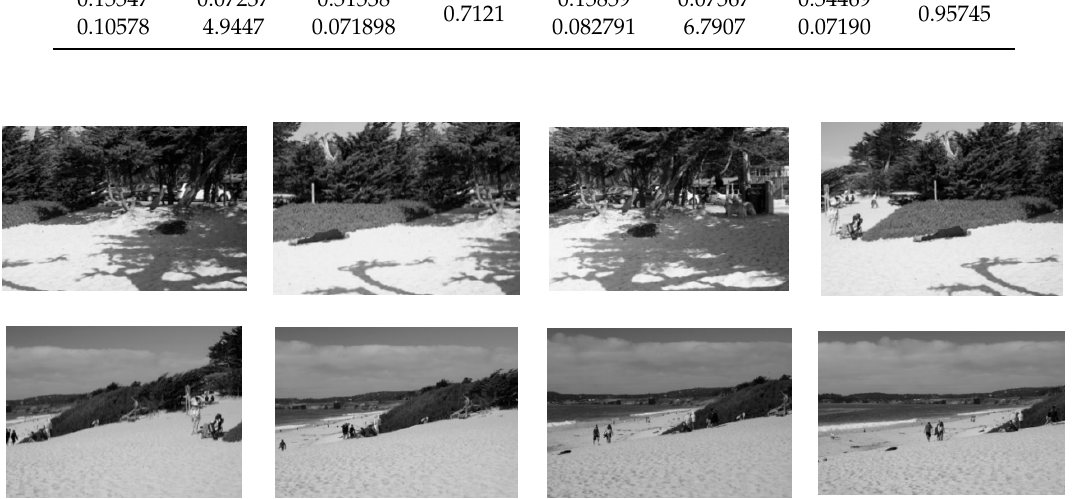
Figure 12. Sample images used in the Carmel Image Figure 12 Sample images used in the Carmel Image Sequence.